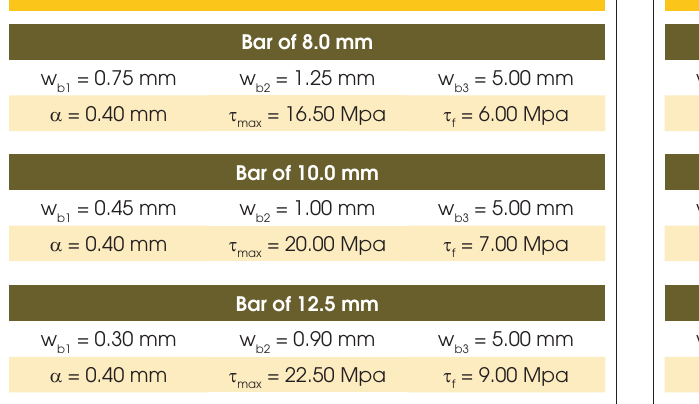
Table 4 – Parameters for the Eligehausen bond law for concrete C25